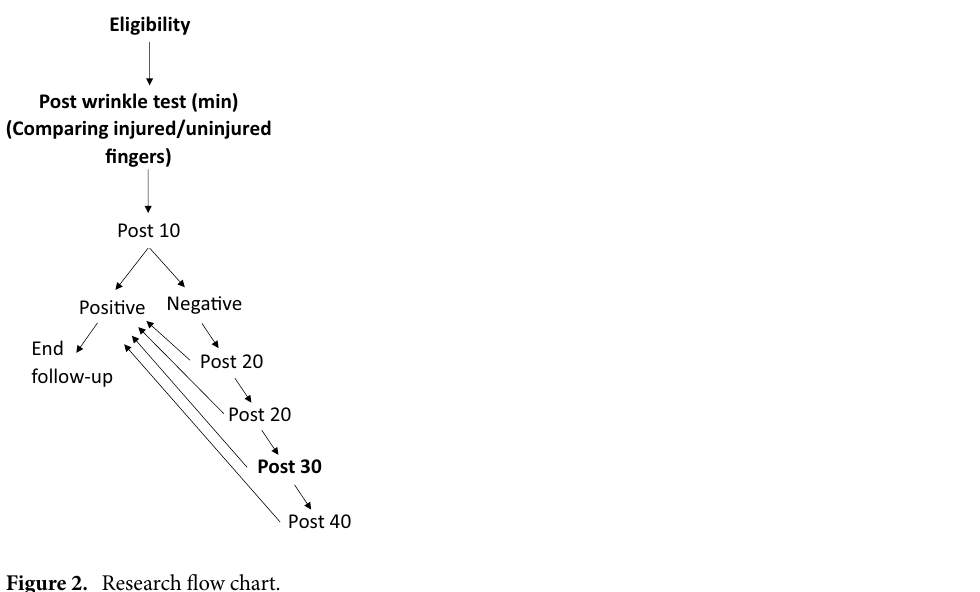
Figure 2. Research flow